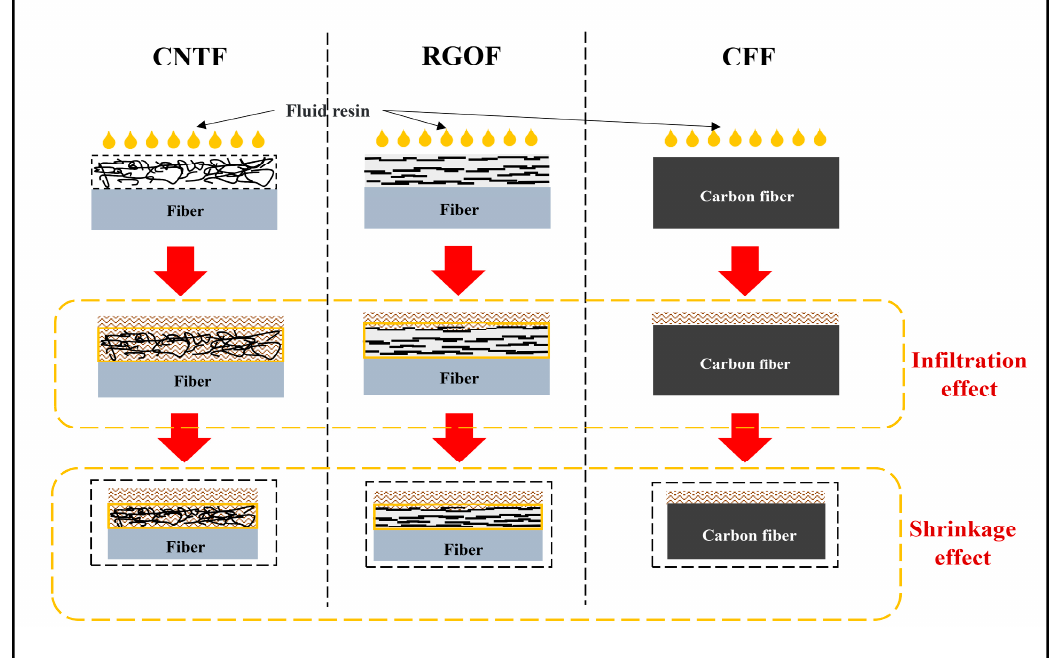
Figure 5. Schematic diagram of the comparison of the CNTF, RGOF, and CFF in the process of composite manufacturing.